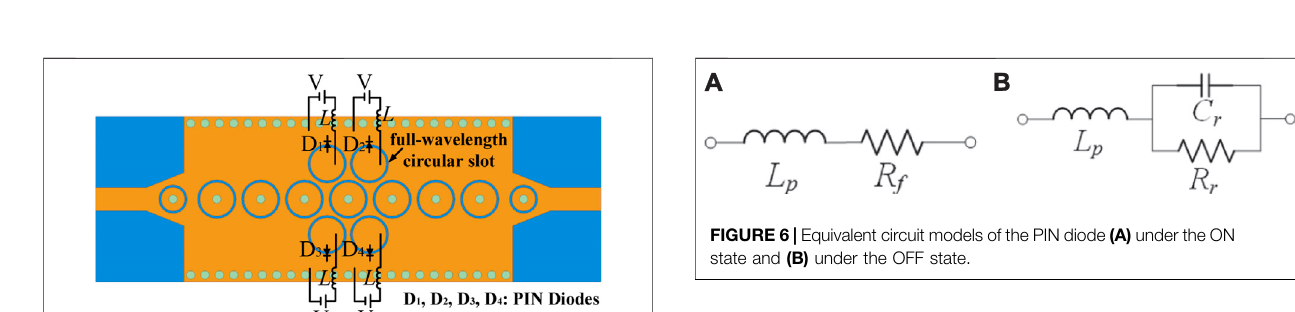
Frontiers in Physics |